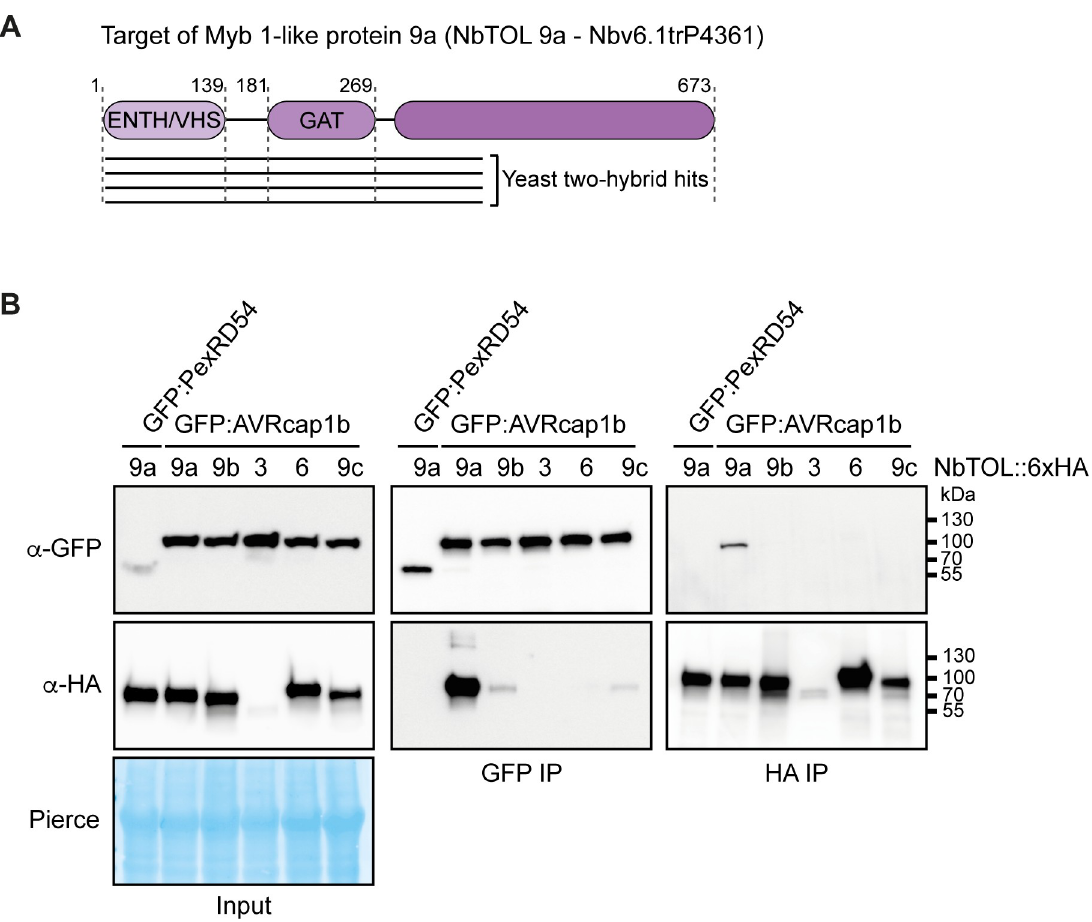
Fig 9. AVRcap1b associates with NbTOL9a in planta . (A) Schematic diagram of domain organisation of NbTOL9a, showing Y2H hits from the screen (S2 Table). (B) CoIP experiment between AVRcap1b and 5 NbTOL family proteins (NbTOL9a, NbTOL9b, NbTOL3, NbTOL6, and NbTOL9c). N-terminally GFP-tagged AVRcap1b was transiently coexpressed with all 5 NbTOL proteins fused to a C- terminal 6xHA tag. N-terminally GFP-tagged PexRD54 was used as a negative control. IP were performed with agarose beads conjugated to either GFP (GFP-IP) or HA (HA-IP) antibodies. Total protein extracts were immunoblotted with appropriate antisera labelled on the left. Approximate molecular weights (kDa) of the proteins are shown on the right. Rubisco loading controls were conducted using Pierce staining. This experiment is representative of 3 independent replicates. coIP, co-immunoprecipitation; IP, immunoprecipitation; NbTOL, N . benthamina Target of Myb 1-like protein; Y2H, yeast two-hybrid.